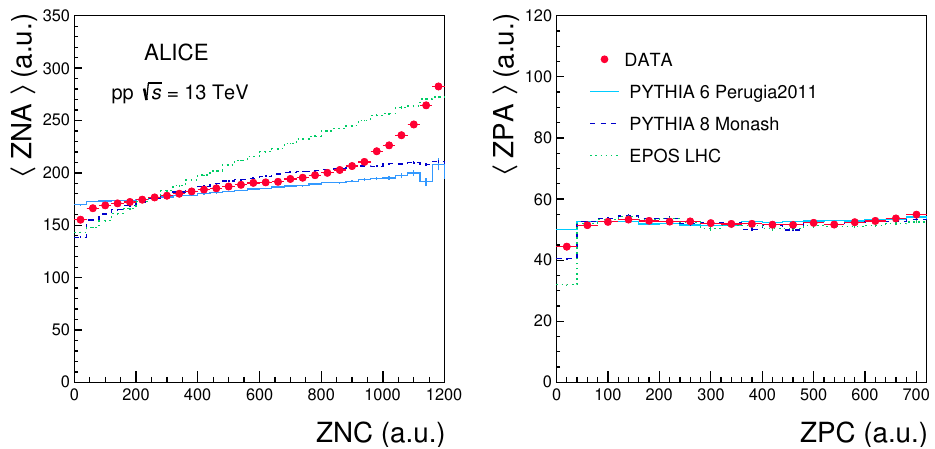
Figure 2 . Average A-side ZN (left) and ZP (right) signals as a function of the C-side signals in √ pp collisions at s = 13 TeV. Data (red full circles) are compared with model predictions from PYTHIA 6 (azure line), PYTHIA 8 (dashed blue line) and EPOS (dotted green